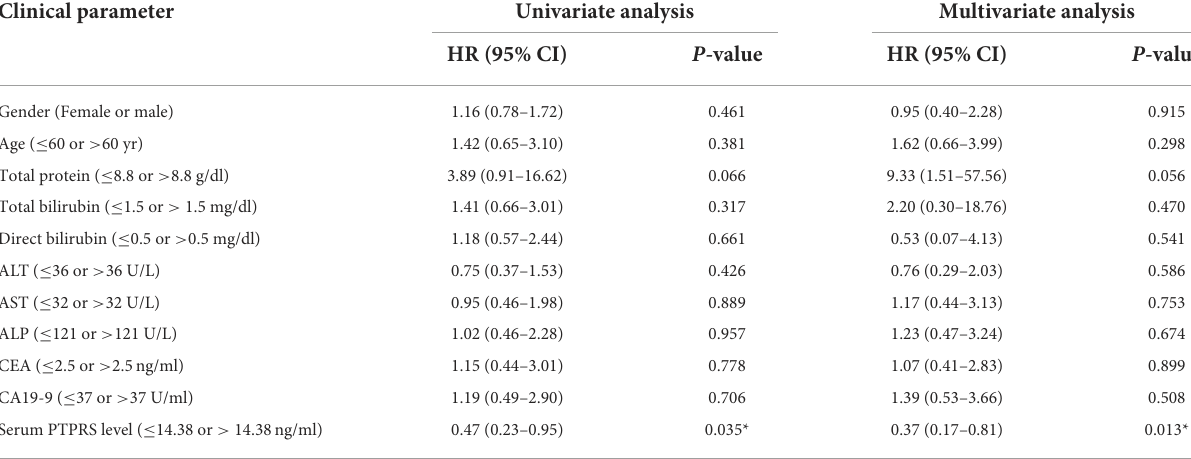
TABLE 4 The Cox proportional hazards regression analysis of clinicopathological parameters and the serum PTPRS level of patients with CCA. Clinical